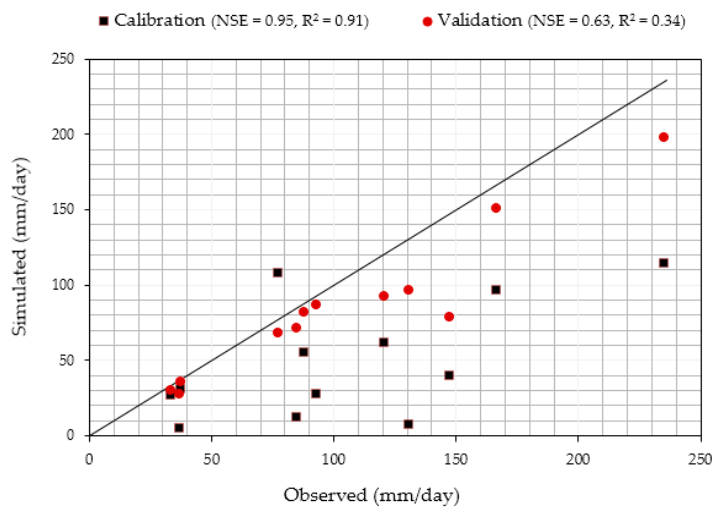
Figure 4. SIMHYD model performance criteria during calibration (black squares) and validation (red circles) results at Balranald sub-catchment (mm/day).